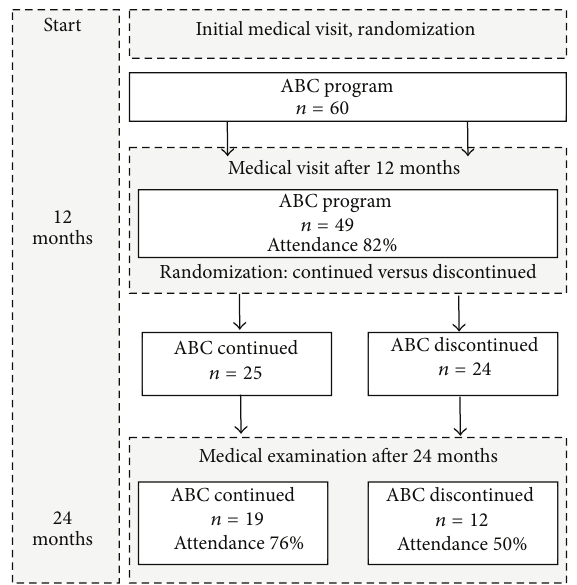
Figure 1: Study design: patients who completed the one-year pro- gram [6] were randomized into two groups. The “ABC continued” group continued telemonitoring and received telecoaching for a second year and was counseled by monthly letters. The “ABC discontinued” group was not contacted for another 12 months until the medical examination after 24